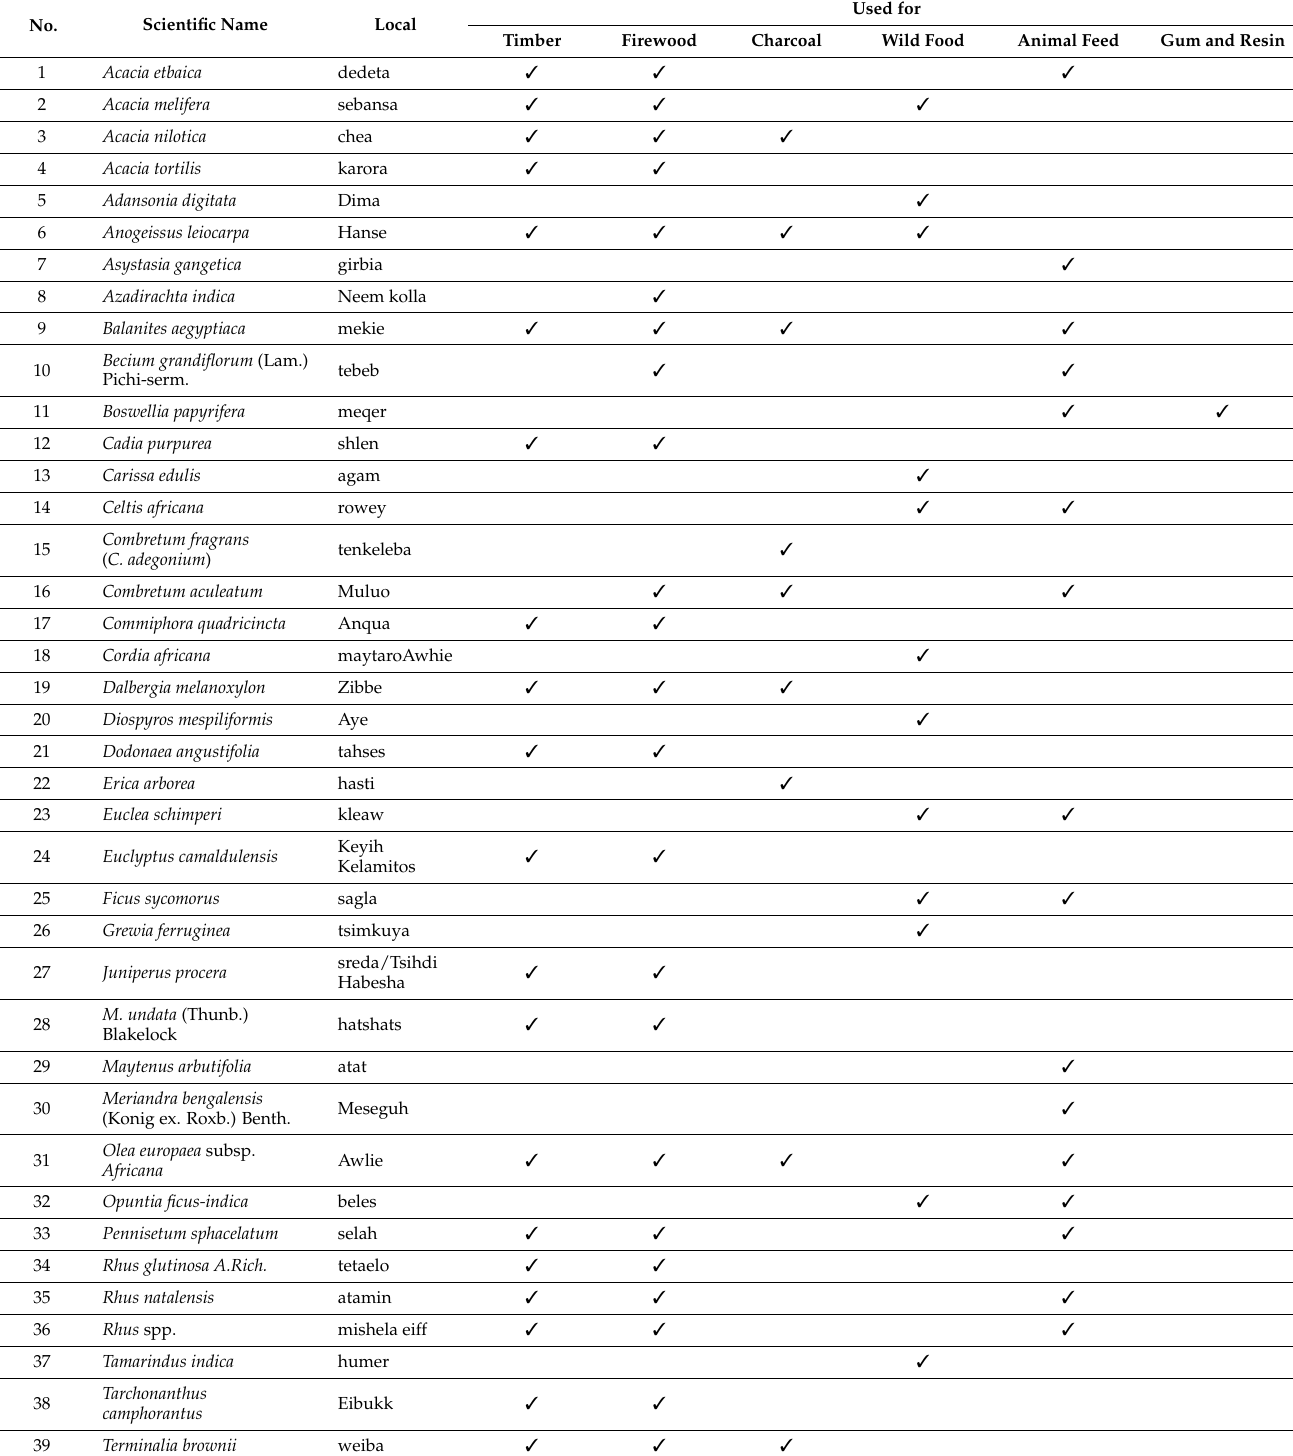
Table A1. Major dry forest species and their uses in the study